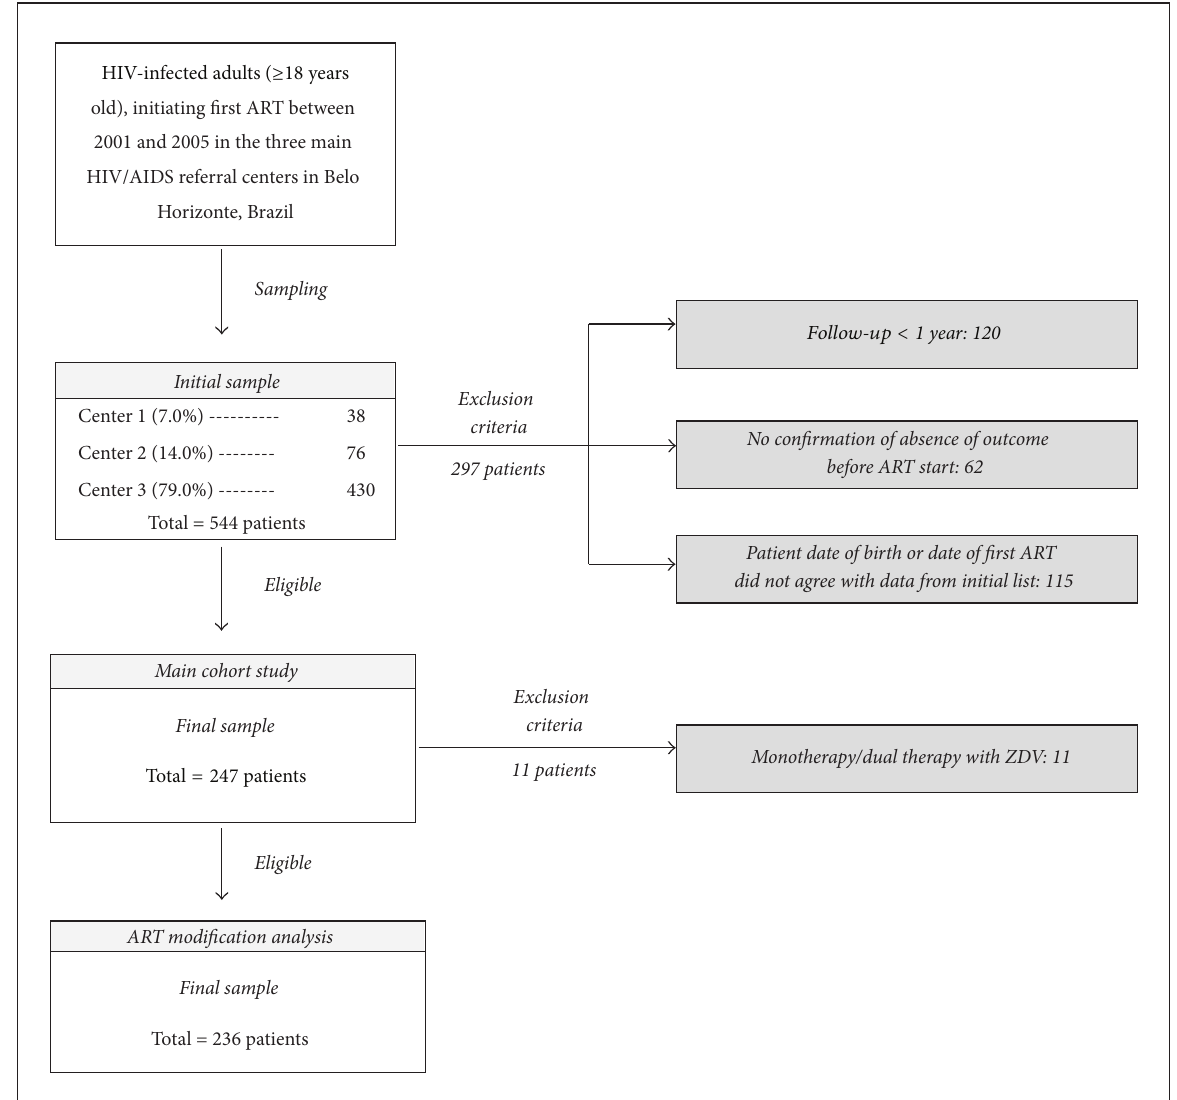
Figure1:FlowchartofselectionofparticipantsfromthemaincohortstudyandfortheARTmodificationanalysis.ART:antiretroviraltherapy. ZDV: